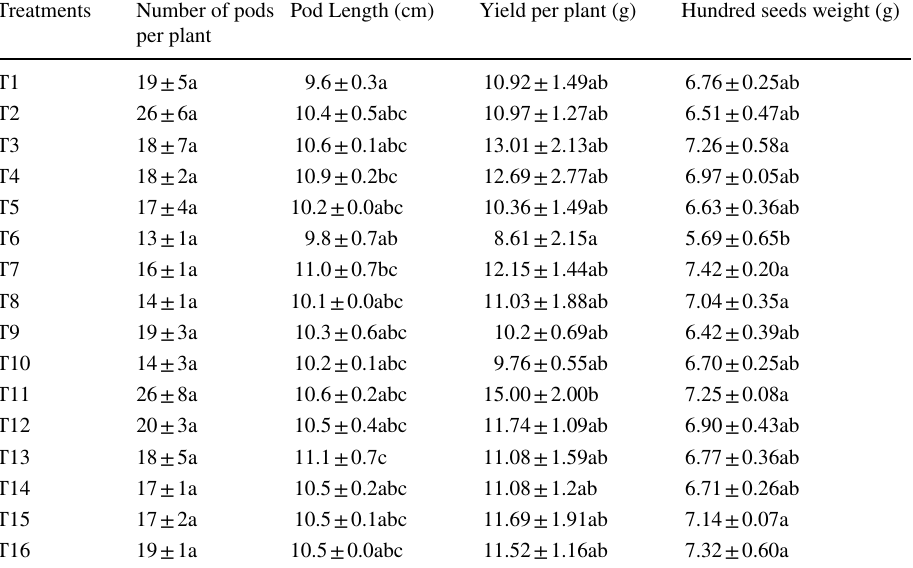
Values are the means of two replications and three plants per replicate Different letters show significant differences according to Duncan’s test (P =